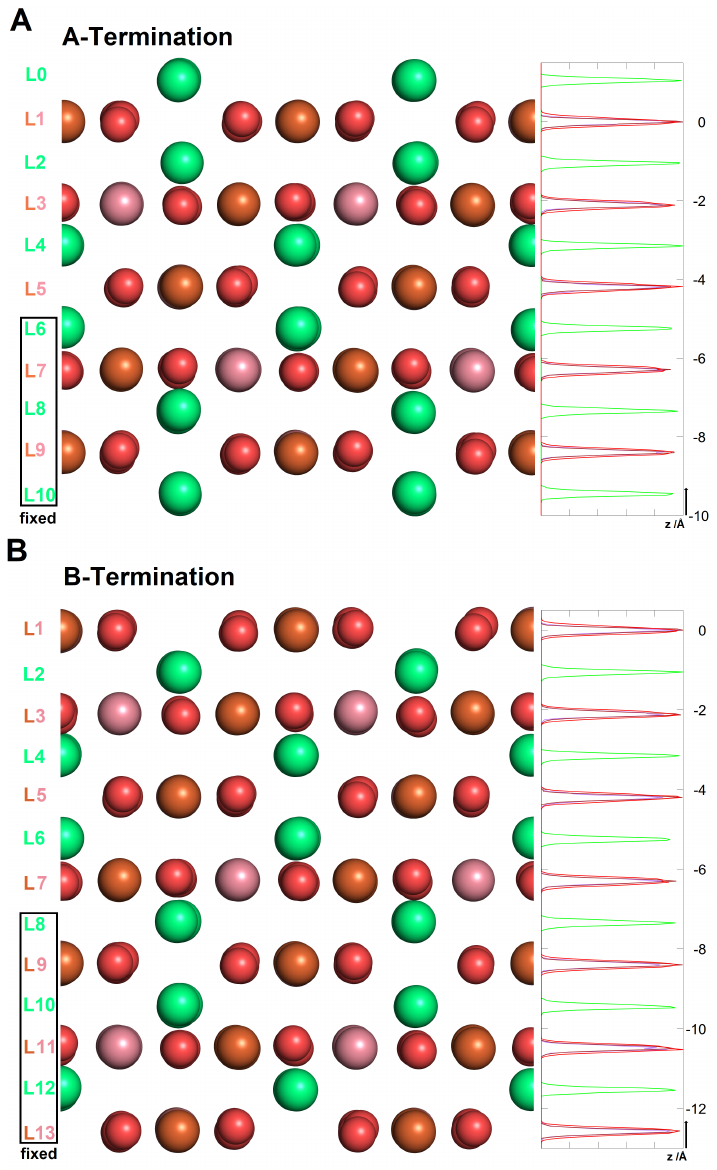
Figure 2. A-(top) and B-(bottom) terminations of the CoFe 2 O 4 (001) surface. Fe 3+ (tet) ions in tetrahe- dral voids are shown in green, Fe 3+ (oct) and Co 2+ (oct) ions in octahedral voids are shown in brown and purple and oxygen atoms are shown in red. On the left, various layers are defined, and atom density profiles along the z axis are shown on the right. Layers L6–L10 and L8–L13 were kept rigid for A- and B-terminations,